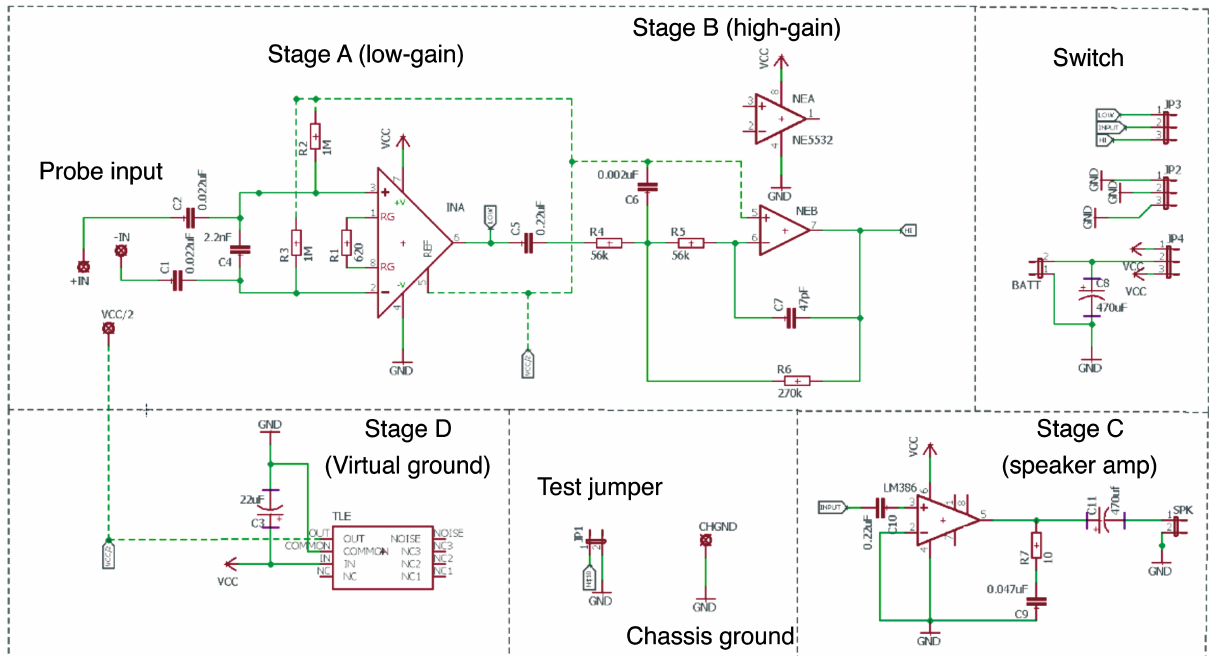
Fig. 1. Electric fish finder circuit schematic in Autodesk Eagle format. BATT = battery, C = capacitor, CHGRND = chassis ground, GND = ground, JP = connector socket, R = resistor, SPK = speaker, VCC = voltage common collector. Integrated circuits are: INA = instrumentation amplifier INA128PA; NEB = operational amplifier NE5532; LM386 = audio amplifier LM386N-1; TLE = virtual ground TLE2425IP. This schematic matches the printed circuit board layout in Fig.